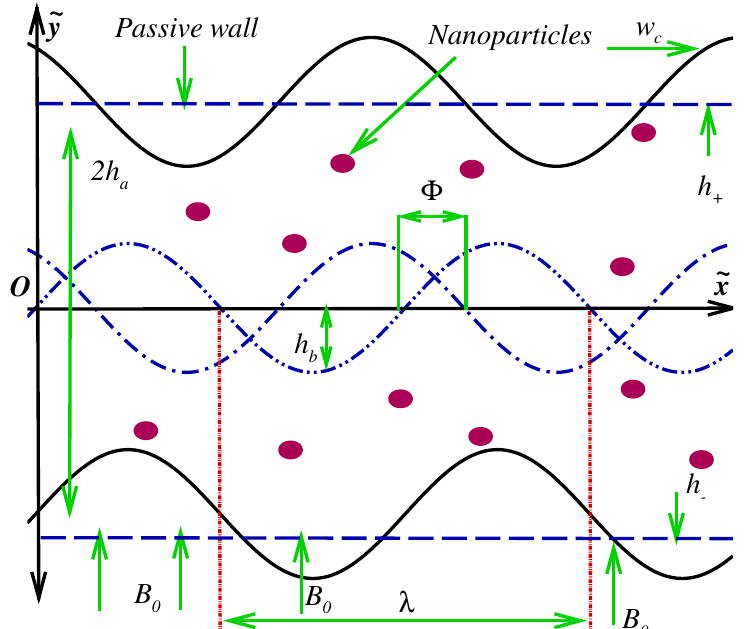
Figure 1. Geometrical structure of the intra-uterine nanofluid flow through asymmeteric